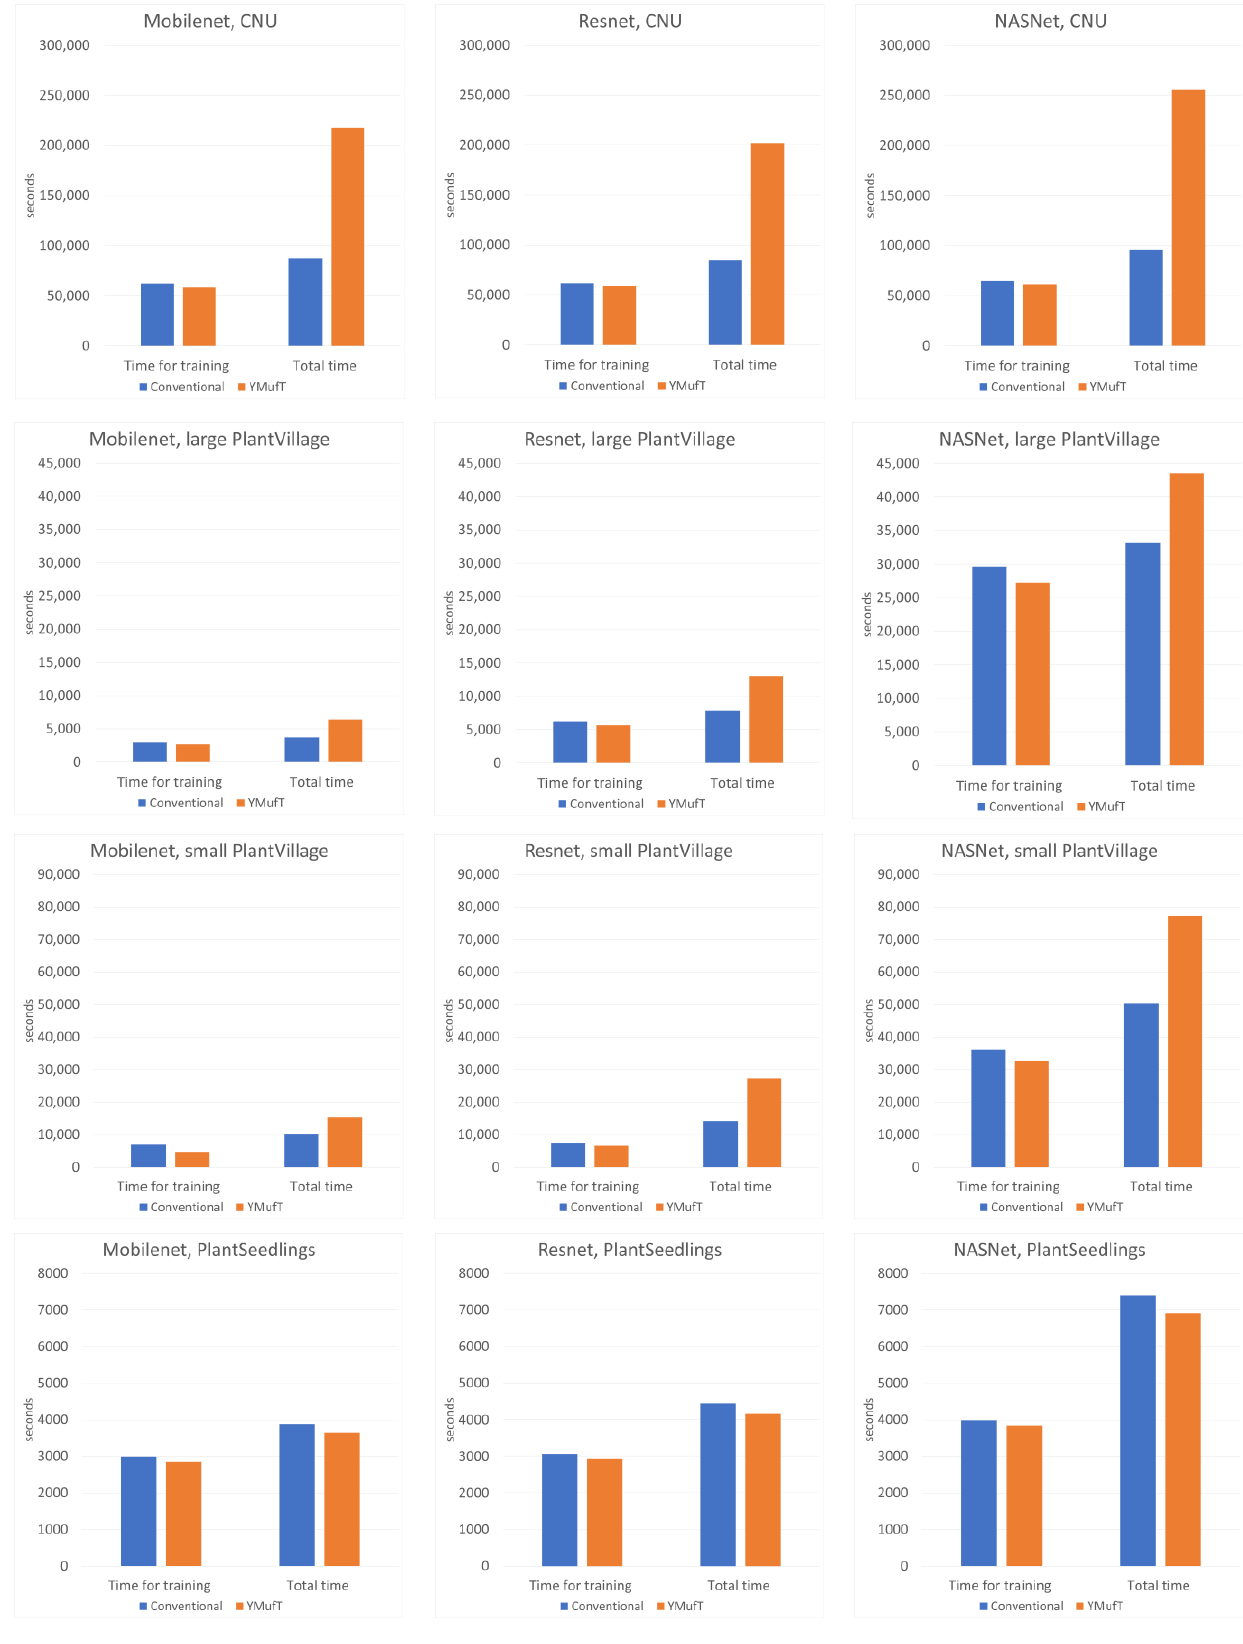
Figure 10. Comparison of elapsed time between the conventional method and YMufT strategy.